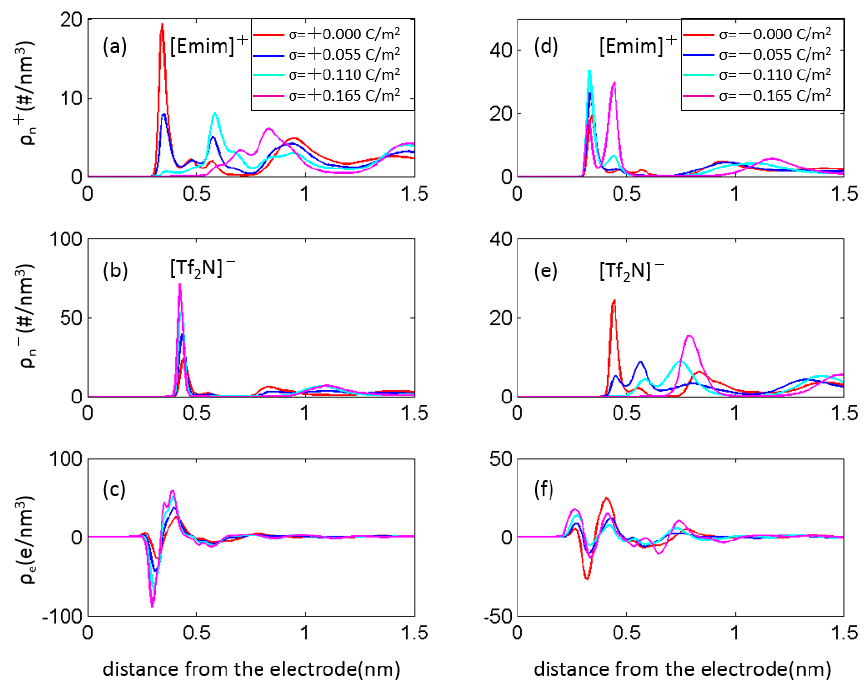
Figure 4. The number density distribution of cations and anions, and space charge density profiles of [Emim][Tf 2 N] near positively-charged electrodes ( a – c ) and negatively-charged electrodes ( d – f ).